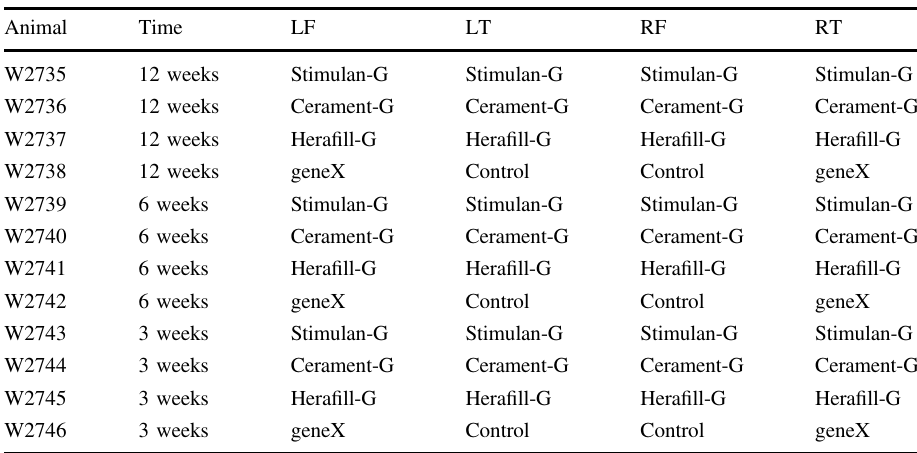
Table above lists the implantation schedule for all twelve animals used in this study. In the case of Stimulan- G, Cerament-G and Hera fi ll-G test groups, all four defects in one animal were all implanted with the same material. For the control animals, two defects were allocated as empty controls (negative control) while two defects were fi lled with geneX paste